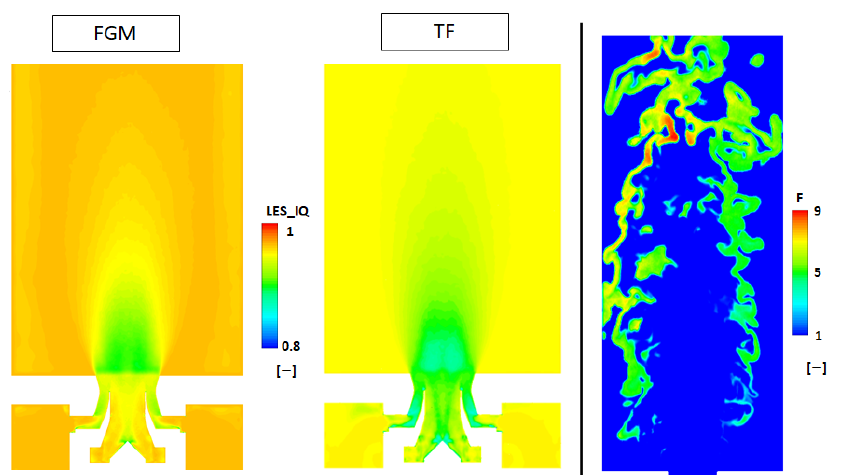
Figure 4. Contour maps of mean LES quality index by Celik [46] for the FGM and the TF simulations ( left ) and instantaneous value of thickening factor F ( right